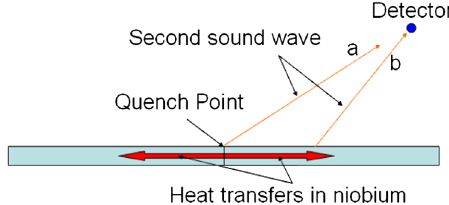
FIG. 12. Second sound wave propagation after quench hap- pens. As the speed of heat transfer in niobium is fast, the temperature at the region near the defect can rise to a high value in a few hundred microseconds. This will cause the result of second sound wave b (not from quench point) reaching the detector before second sound wave a (from quench point).